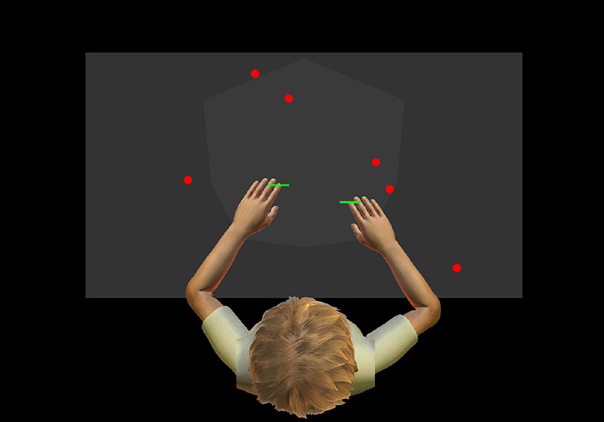
Figure 2. Schematic of the object hit task virtual workspace. Green paddles were displayed on participants fingertips. Participants then attempted to hit as many red balls away from them as possible, as the balls were dropped from the top of the